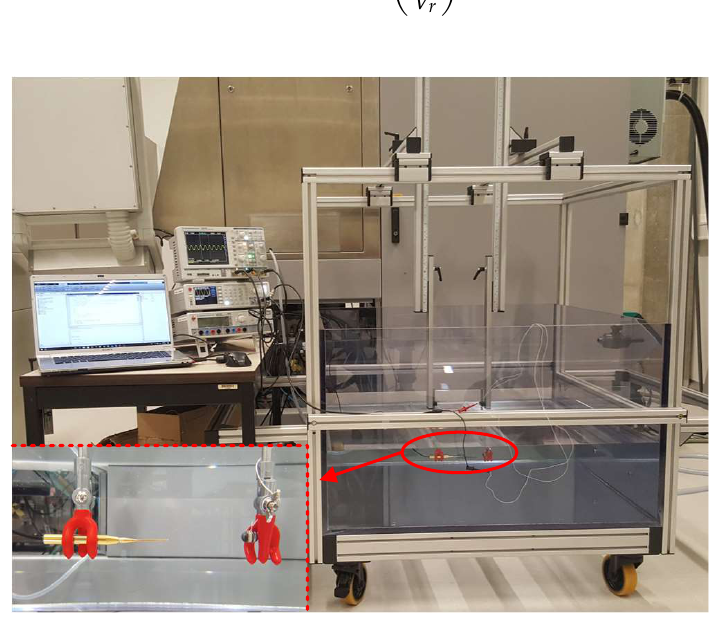
Figure 10. The in-house built measurement setup to characterize the resonating shell transducer.